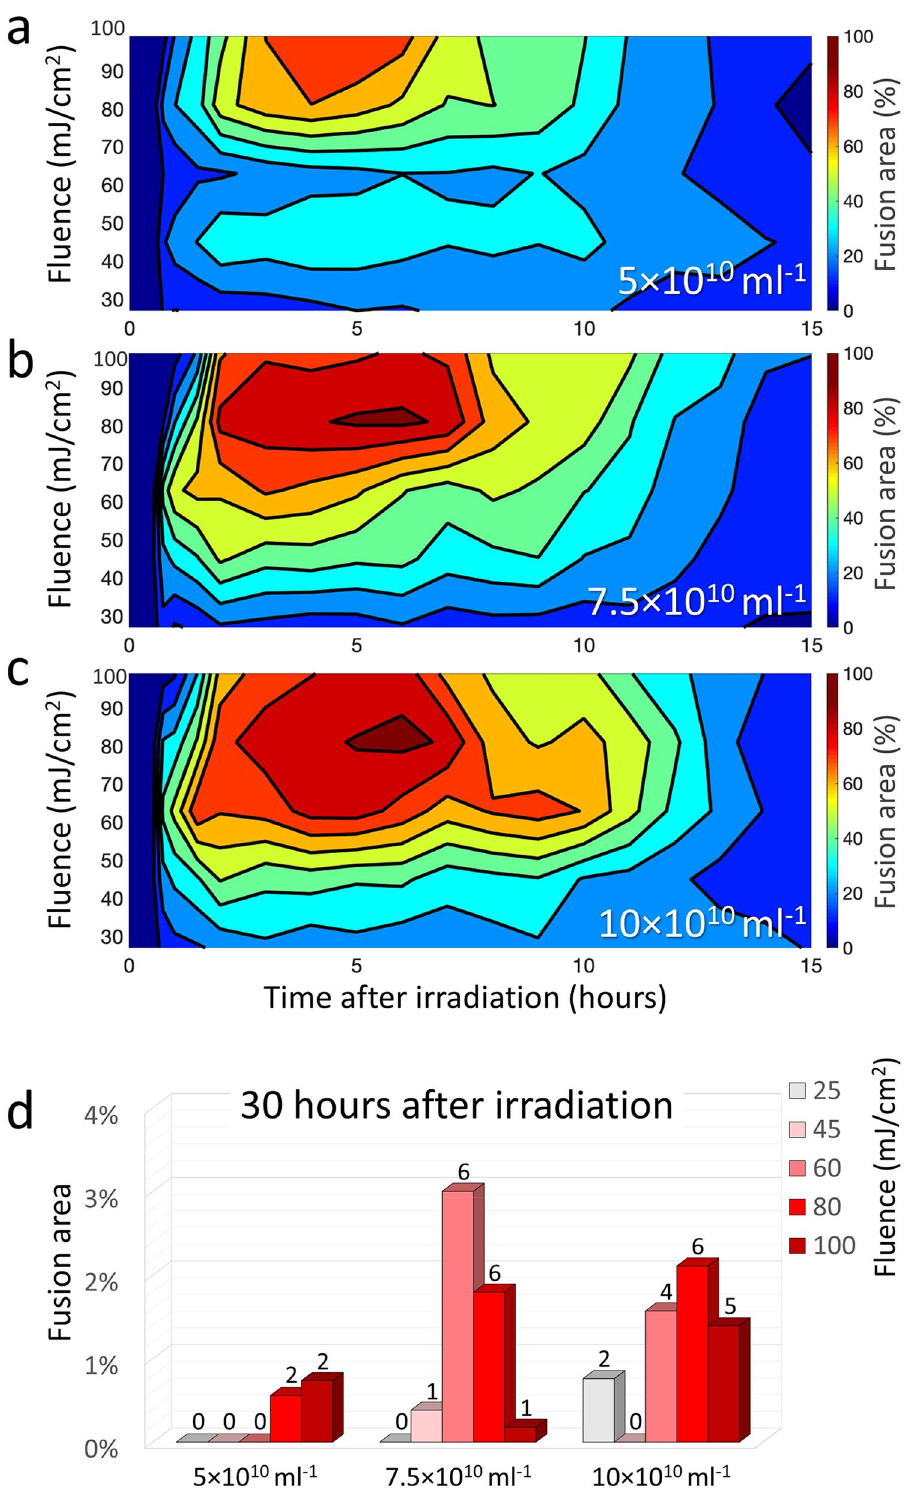
Figure 3. Relative fusion efficiency as function of fluence levels and times after irradiation for three nanoparticle concentrations of ( a ) 5 × 10 10 ml −1 , ( b ) 7.5 × 10 10 ml −1 , and ( c ) 10 × 10 10 ml −1 . Higher particle concentrations have resulted in larger areas of fused cells, even for moderate fluence levels. ( d ) Percent of viable fused cells 30 h after irradiation by the different fluence levels. The number above each bar represents the total number of multinucleated cells in the respective